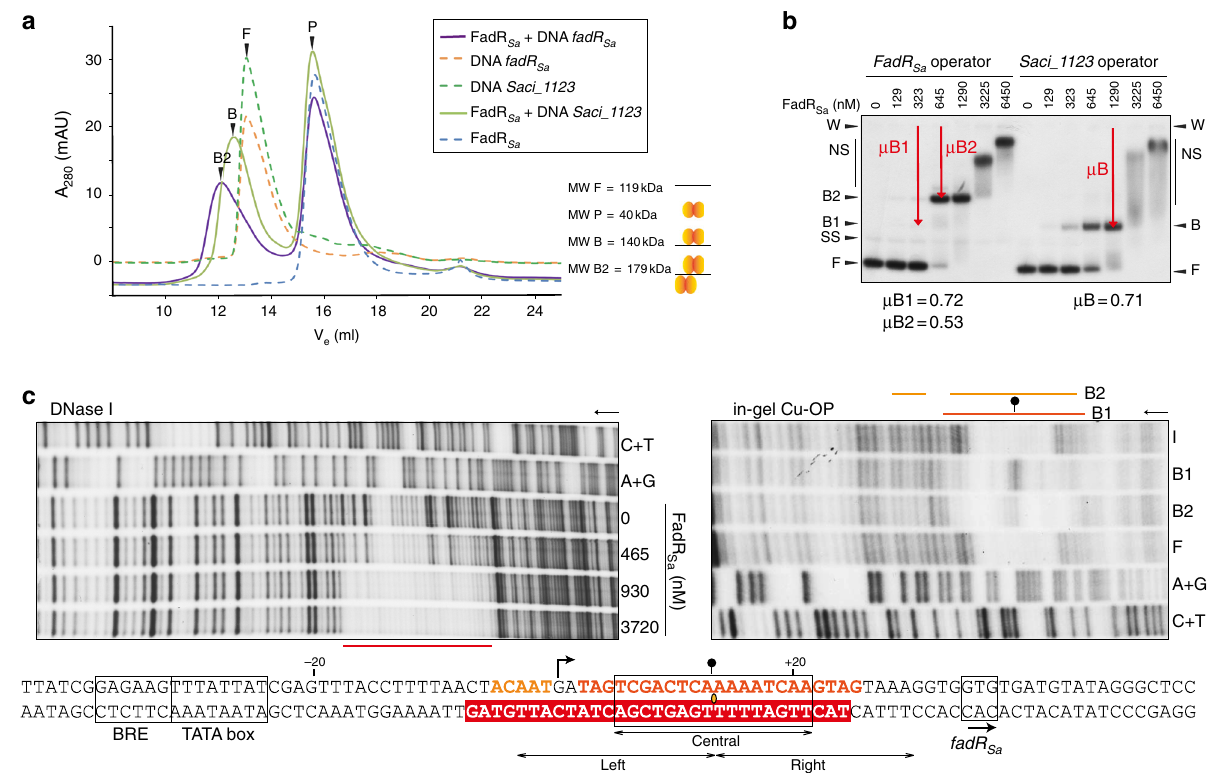
Fig. 4 FadR Sa interacts in different stoichiometric binding modes with different operators. a Size-exclusion chromatography experiment of FadR Sa – DNA complexes with 45-bp DNA fragments. Totally, 0.2 nmol DNA and 8 nmol FadR Sa was used resulting in a 40:1 FadR Sa :DNA molar ratio upon mixing. Apparent molecular weights (MWs) based on K av calculations are mentioned for the peaks representing free DNA (F), FadR Sa protein (P) and FadR Sa – DNA complexes B and B2. b Electrophoretic mobility shift assay (EMSA) monitoring interaction with probes representing the fadR Sa and Saci_1123 operator. Molar protein concentrations are indicated and populations of single-stranded DNA (SS), free DNA (F), and FadR Sa -bound DNA (B, B1, and B2) are indicated with an arrowhead. “ W ” corresponds to the well position. Relative mobilities μ are de fi ned as the distance between the well position and complexed DNA divided by the distance between the well position and free DNA. c Autoradiographs of DNase I (bottom-strand labeled DNA) and “ in-gel ” Cu-phenantroline (Cu-OP) (top-strand labeled DNA) footprinting experiments analyzing FadR Sa binding to a probe representing peak 2 in the Saci_1106- Saci_1107 intergenic region ( fadR Sa operator). A + G and C + T denote purine- and pyrimidine-speci fi c Maxam – Gilbert sequencing ladders, respectively. I denotes input DNA (taken from a protein-free lane in the EMSA), F denotes the population of free DNA, while B1 and B2 denote different FadR Sa :DNA complex populations in accordance with the notation in the corresponding EMSA (second autoradiograph in Fig. 2d). The I and F samples generated a sequence-dependent cleavage pro fi le. Protected zones are indicated with a horizontal line while a hyperreactivity site is pointed out with a ball-and-stick symbol. Below the autoradiographs, the nucleotide sequence is shown with a summary of the observed protection zones and hyperreactivity effect, the latter indicating FadR Sa -induced DNA bending and being more pronounced for B1 than for B2. White letters in a red background represent the protection zone observed in DNase I footprinting, whereas orange letters represent the protection zone observed in Cu-OP footprinting. The predicted pseudopalindromic FadR Sa recognition site is boxed with indication of the center of dyad symmetry. The transcriptional start site, indicated with an arrow, is based on observations in ref.